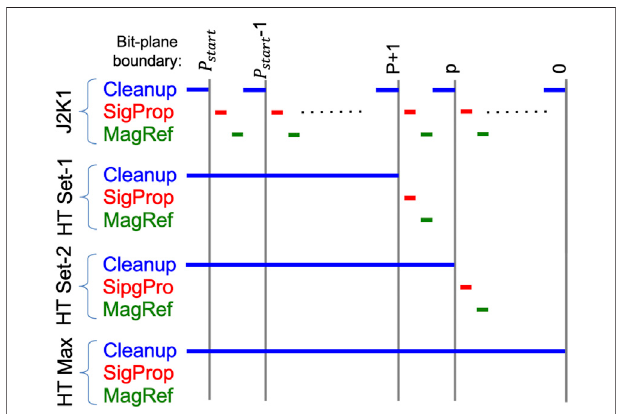
FIGURE 1 | Bit-plane contributions of the coding passes produced by the J2K1 and HT algorithms.